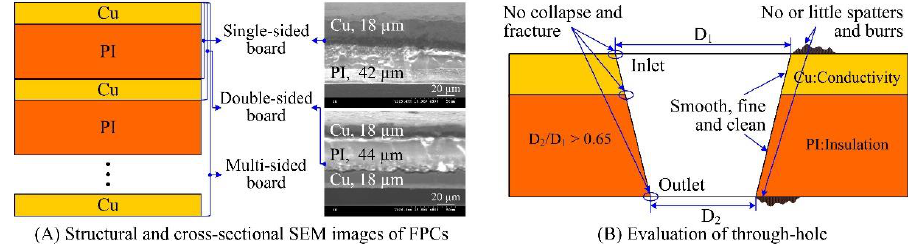
Figure 1. Geometry of Flexible Printed Circuits (FPCs) and the evaluation of through-hole in